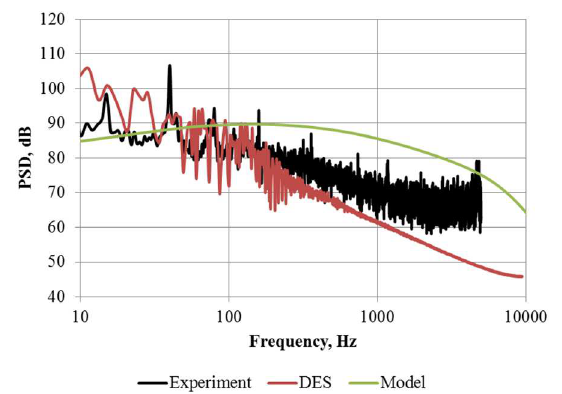
Fig. 15. Comparison of PSD at point № 8 based on the different approaches.